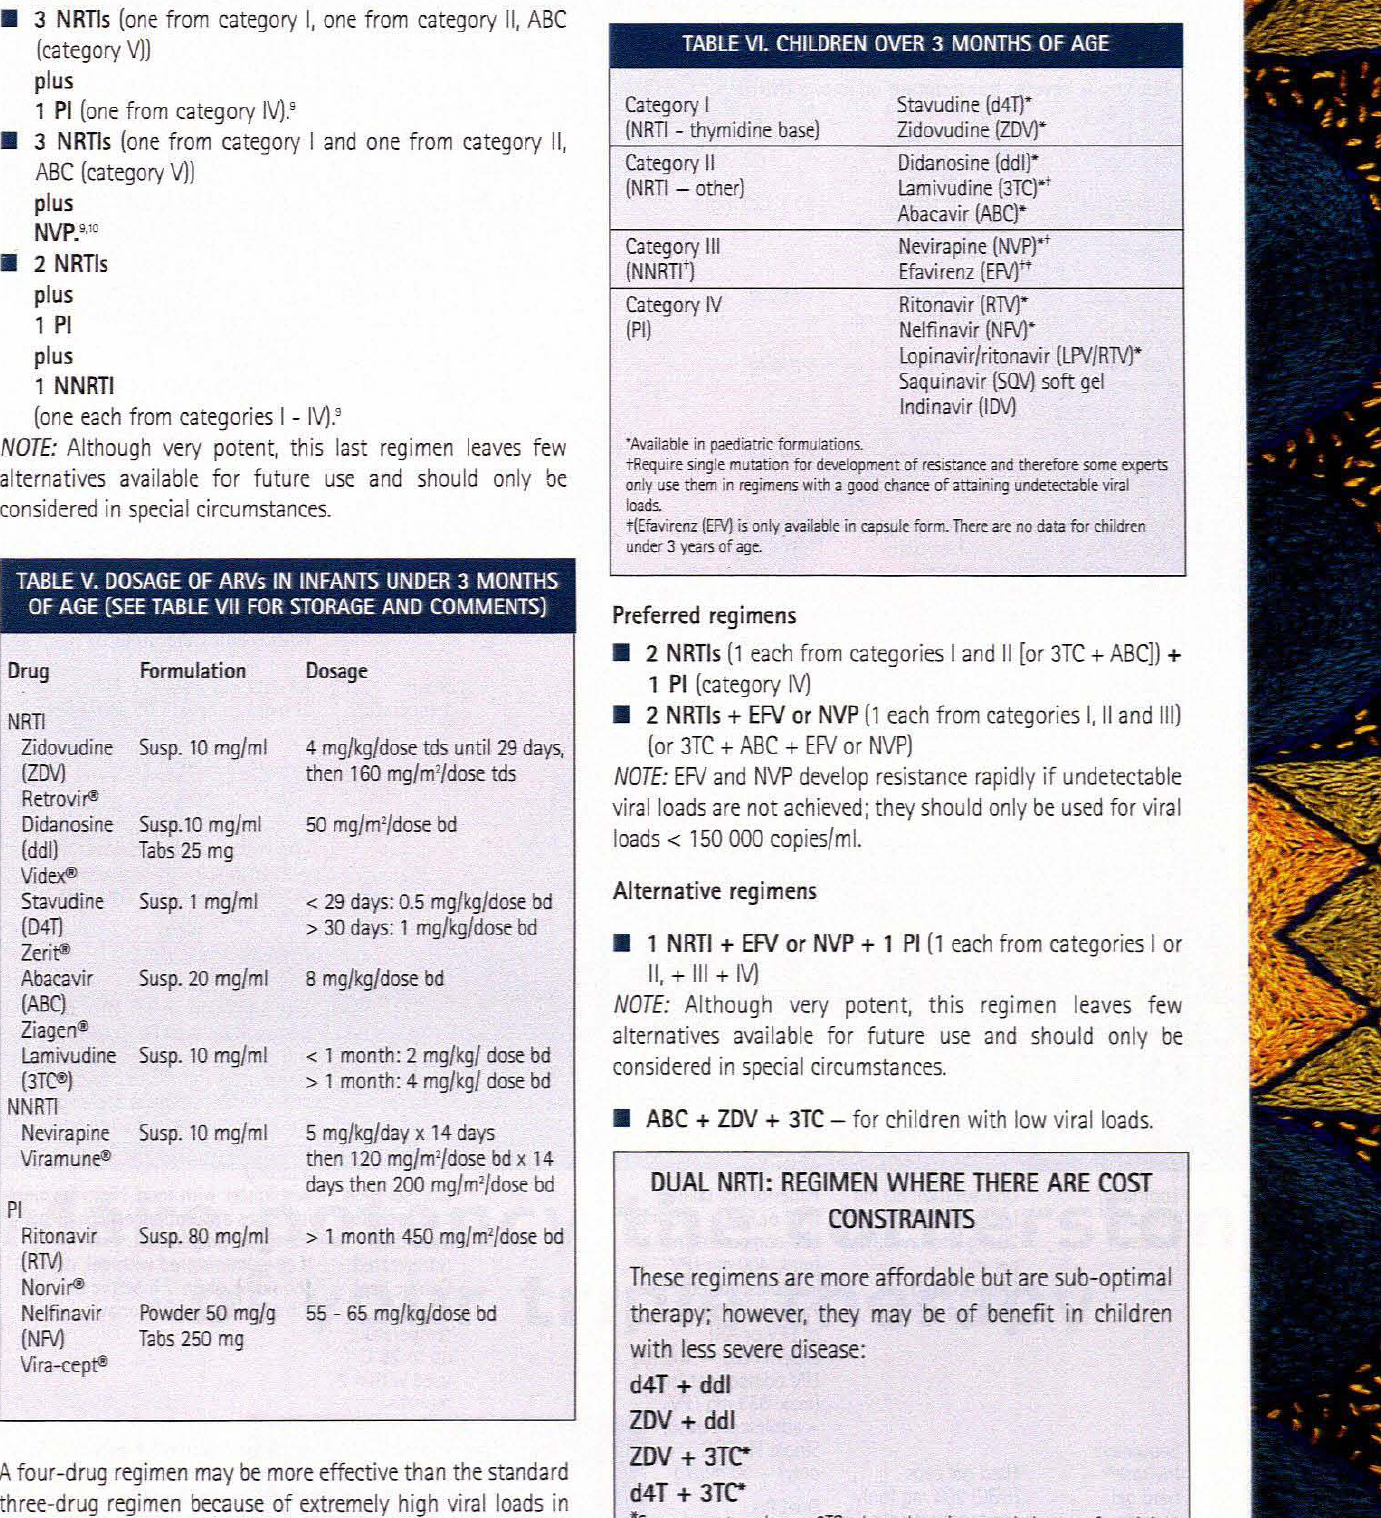
TABLE V. DOSAGE OF ARVs IN INFANTS UNDER 3 MONTHS OF AGE (SEE TABLE VII FOR STORAGE AND COMMENTS)